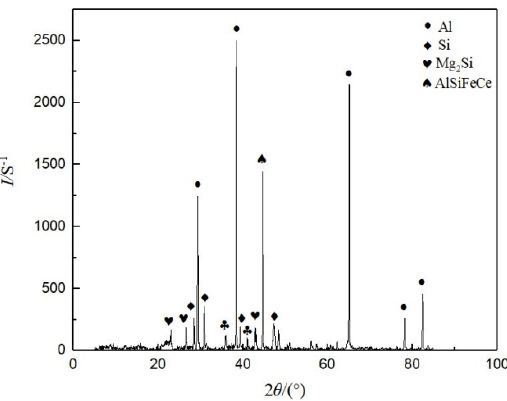
Figure 5. XRD diagram of alloy sample.